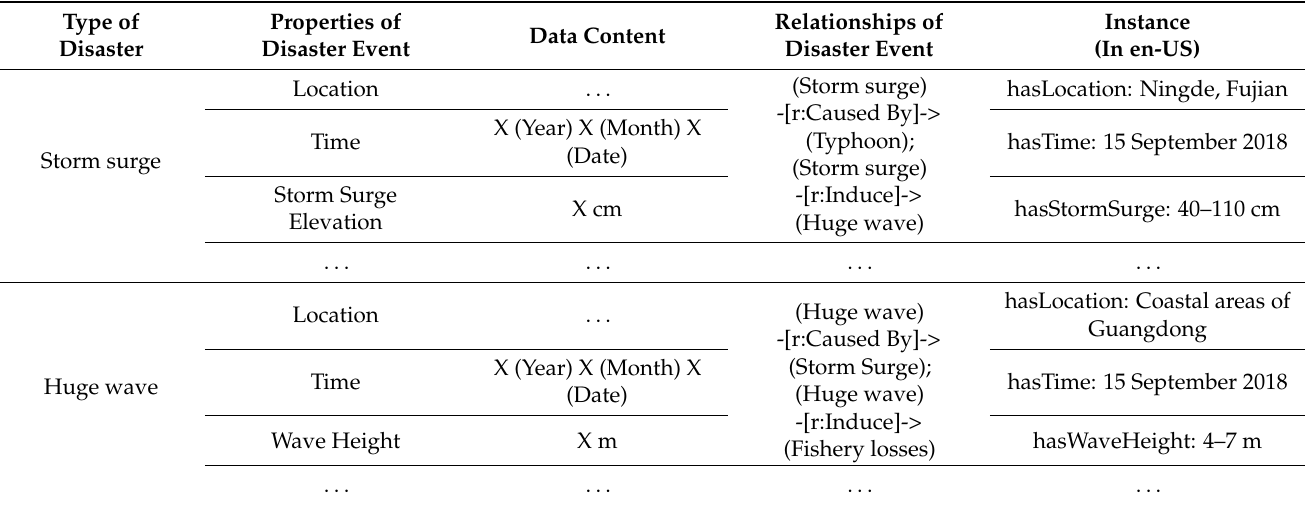
Table 3. Part of Disaster Event